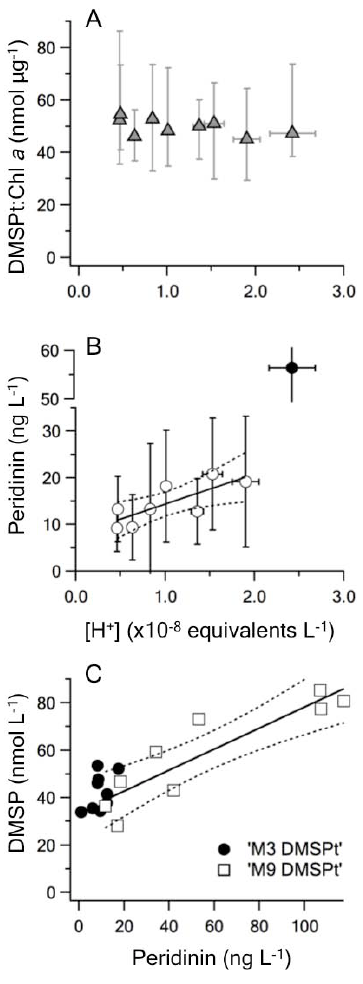
Fig. 6. Pigment concentrations in relation to DMSPt and acidifi- cation during PII: (A) DMSPt:chl a ratio versus [H + ]. Values for DMSPt:chl a are the mean during PII in each mesocosm, bars show the range. Values for [H + ] are the mean ± SD. (B) Peridinin ver- sus [H + ]. Values for peridinin and [H + ] are mean ± SD. Coeffi- cients of the linear regression ( y = a + bx ) based on the full dataset ( n = 63): a = 7 . 7 ( ± 2.9SE), b = 7 . 3 ( ± 2.6SE), ( P = 0 . 007). Note values from the highest [H + ] are not included in the regression. (C) DMSPt versus peridinin concentrations in mesocosm 3 (not significant) and mesocosm 9. Coefficients of the linear regression are: a = 34 ( ± 6SE), b = 0 . 44 ( ± 0.08SE); ( P = 0 . 001). The dot- ted lines show the 95% confident intervals in each